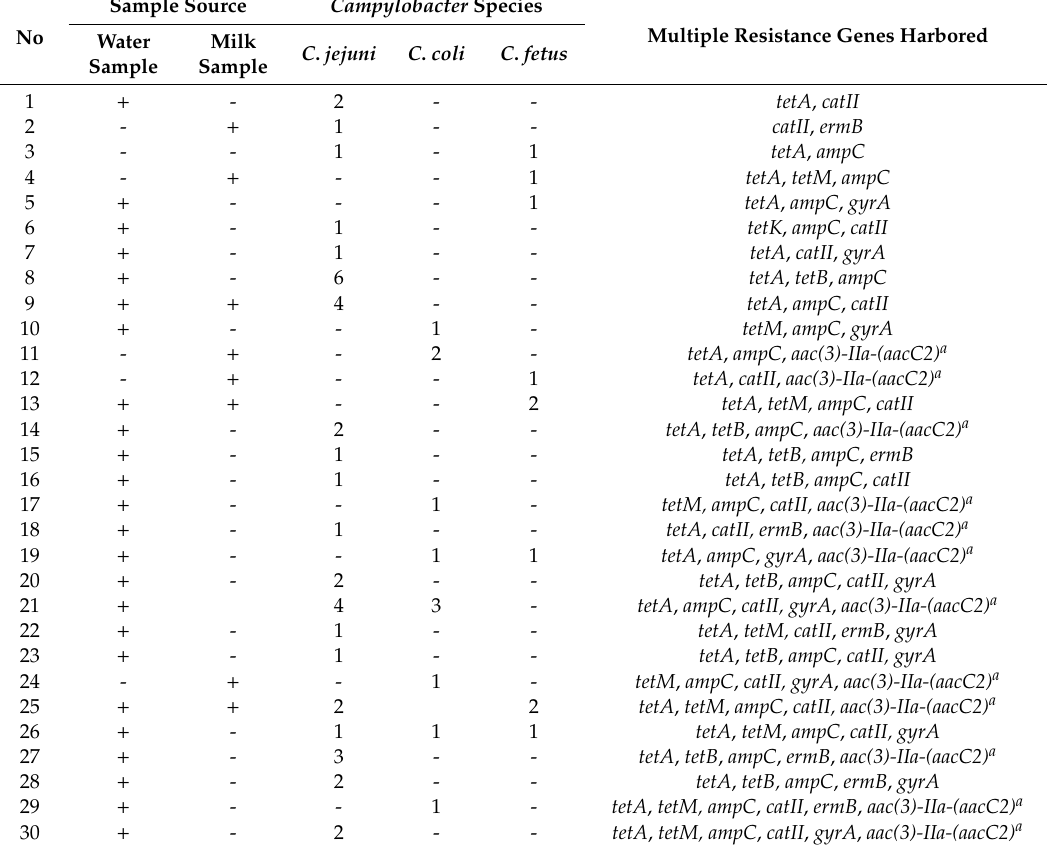
Table 4. Multiple antibiotic resistance genes in C . fetus , C. jejuni and C . coli